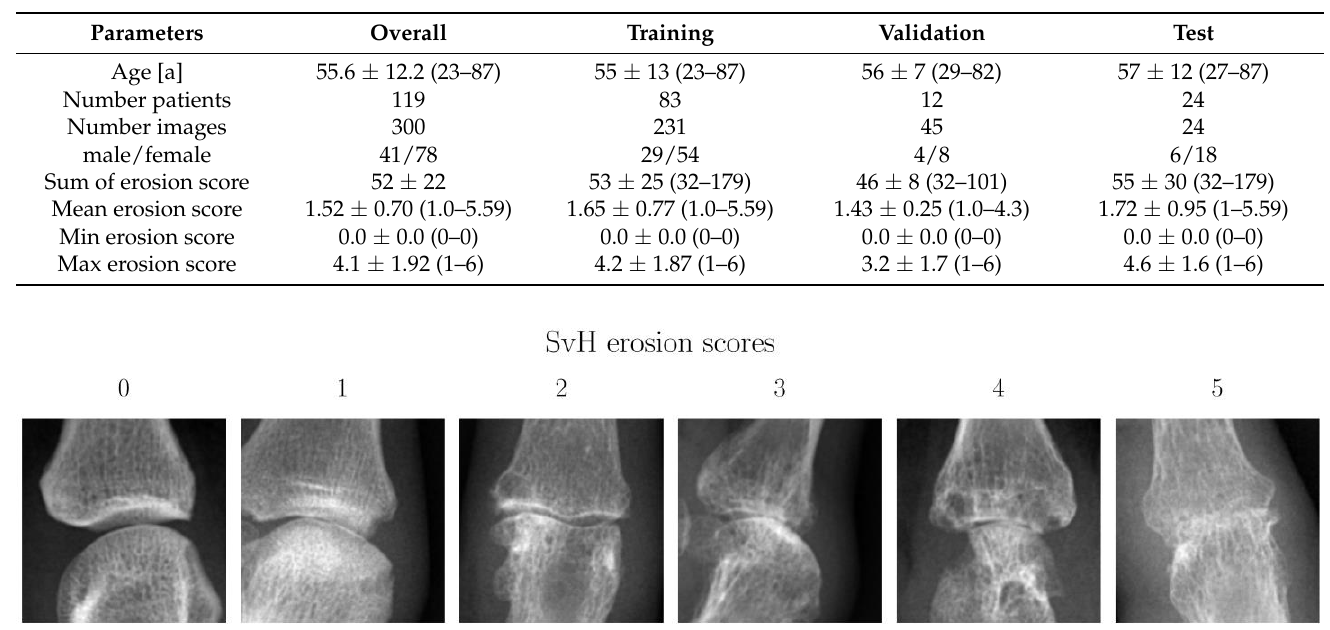
Figure 1. Representative conventional radiographs (CR) of finger joints as a function of damage, classified according to the Sharp van der Heijde (SvH) method by an experienced rheumatologist. From left to right, finger joints are sorted by SvH score from normal (SvH score = 0) to severely damaged (SvH score = 5) joint. Above each image, the respective score is indicated.